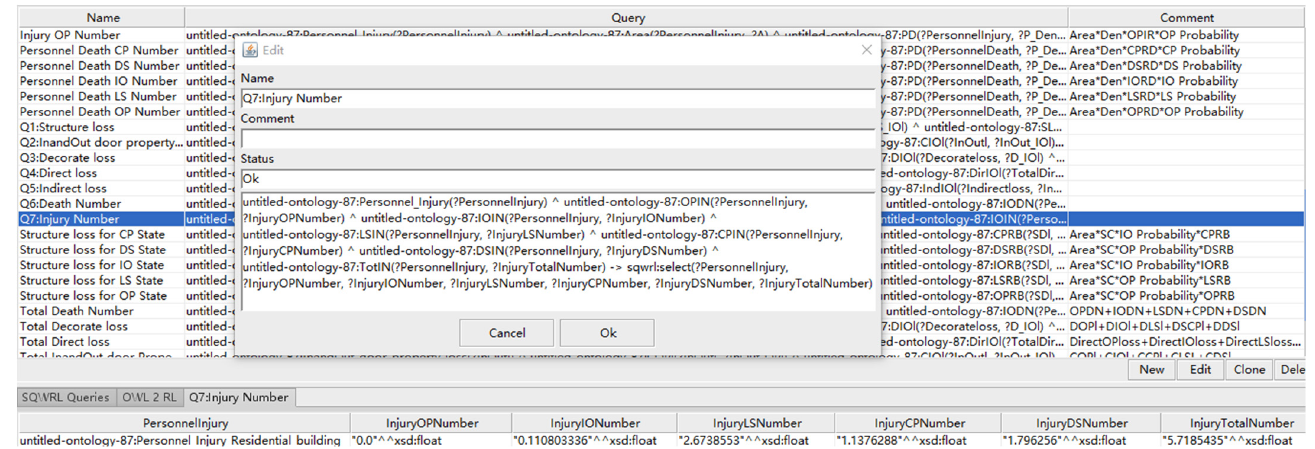
Figure 14. Inference results of querying according to the SQWRL rule Q7 in Table 12.